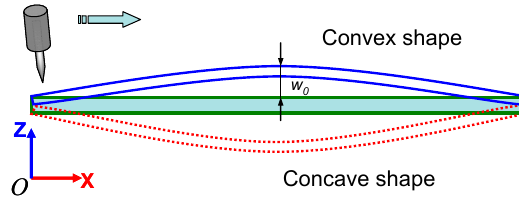
Figure 11. Different shapes of the plate before welding.